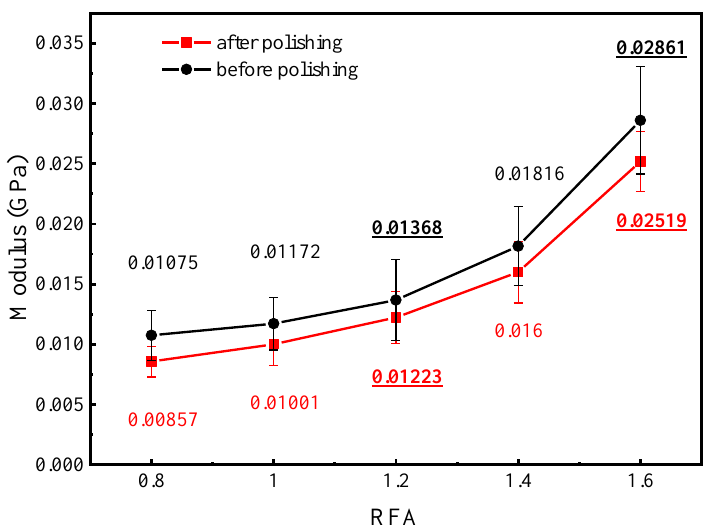
Figure 11. Different rates of filler and asphalt load depth curves before and after polishing. Figure 12. Nanoindentation modulus of asphalt mastic specimens. (As can be seen from the underlined data, the nanoindentation modulus of the RFA 1.6 was approximately twice the modulus of RFA 1.2).